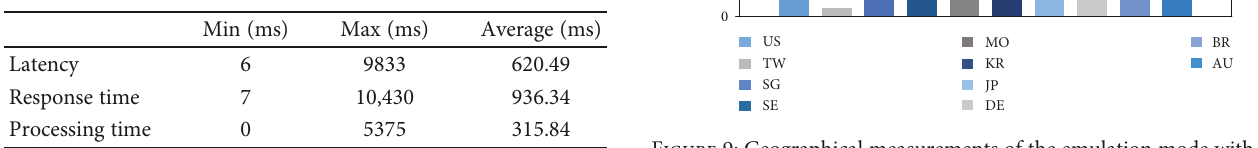
Table 5: Test result of the emulation mode with hop (performance measurements).